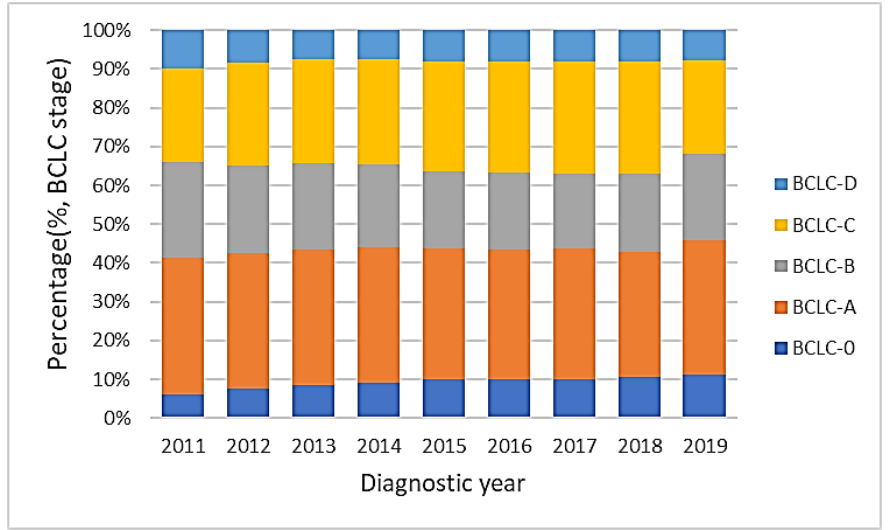
Figure 6. The distribution of BCLC stages from 2011 to 2019. The proportion of BCLC stage 0 in- creased from 6.2% to 11.3% ( p value for linear trend <0.01), while the proportion of both BCLC stages A and B decreased ( p values for linear trend <0.01). The sum of BCLC stages 0, A and B did not change significantly.